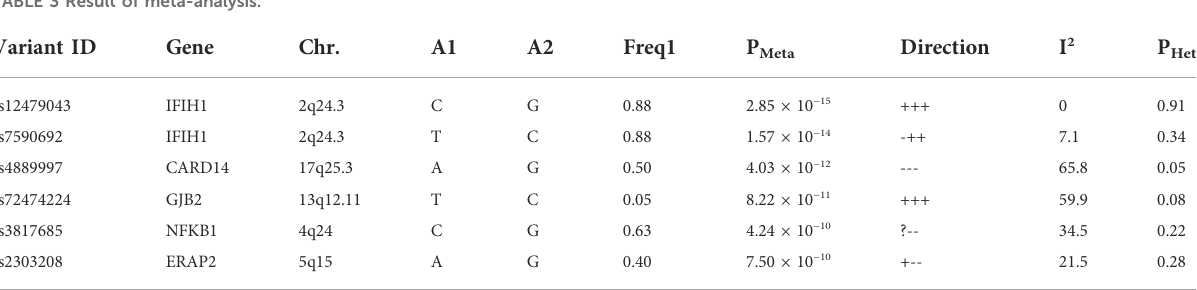
TABLE 3 Result of